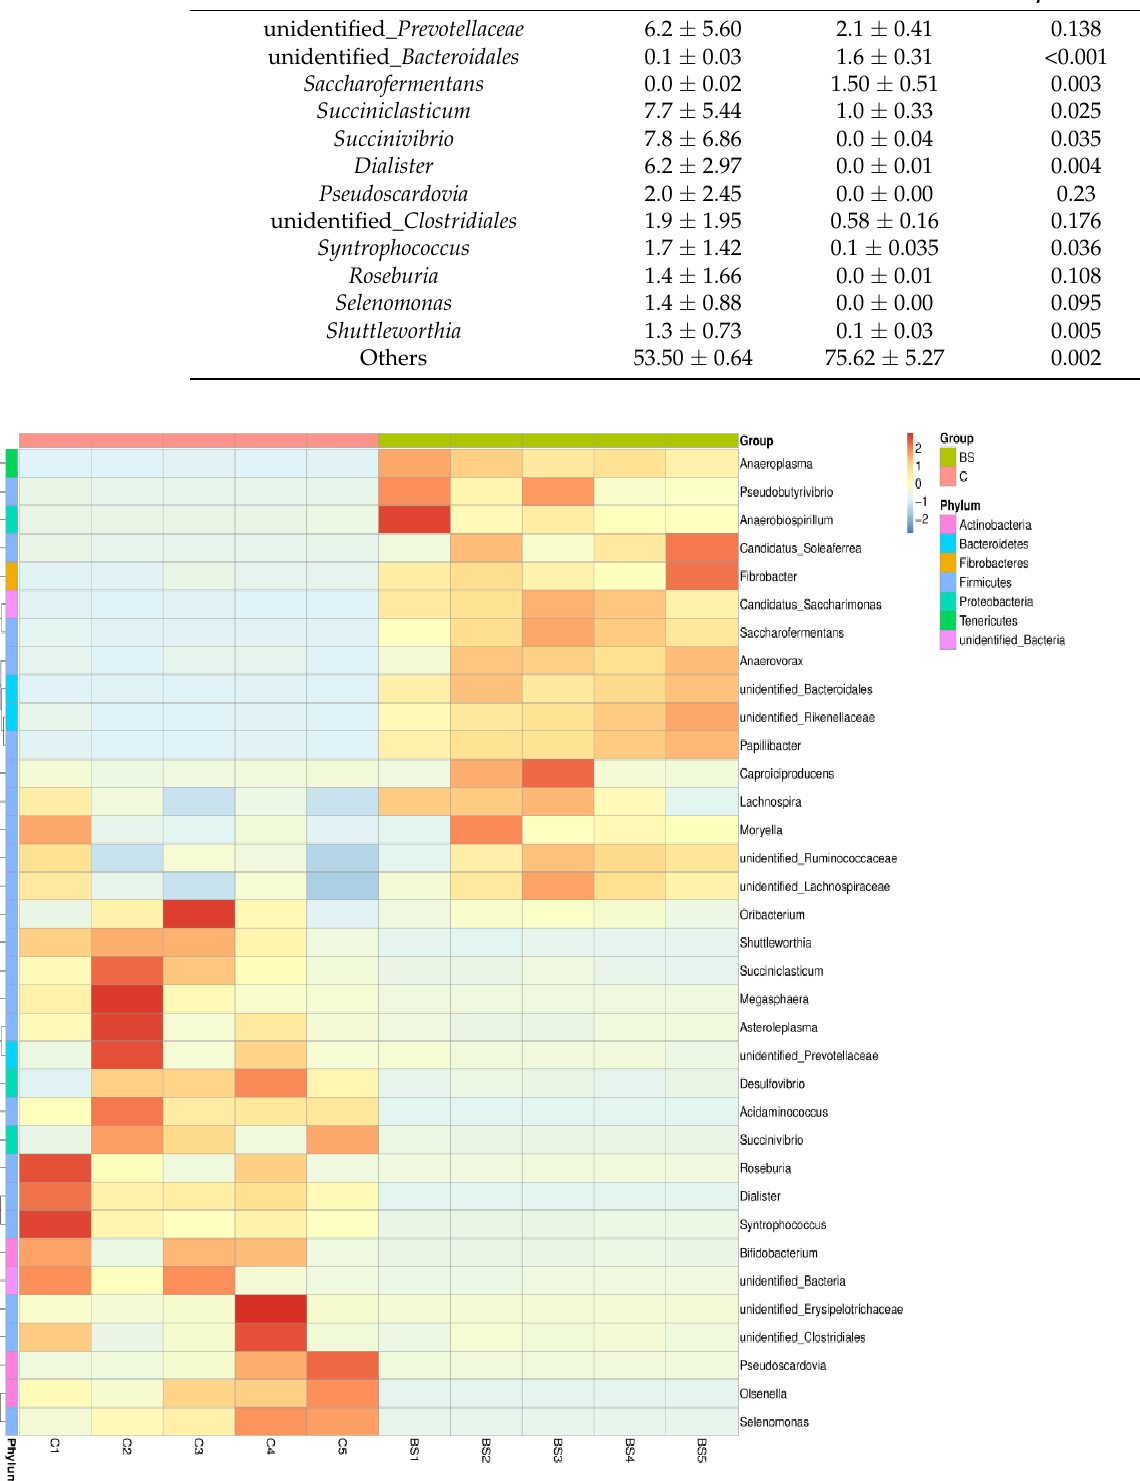
Figure 5. Heat map of genus-level classification. Table 5. Abundance (mean ± SE; n = 5; >1%) at genus level of bacteria in the rumen fluid of lambs fed basal diet only (Control; C) or basal diet supplemented with Bacillus subtilis at the concentration of 3 × 10 8 CFU/kg DM (BS).